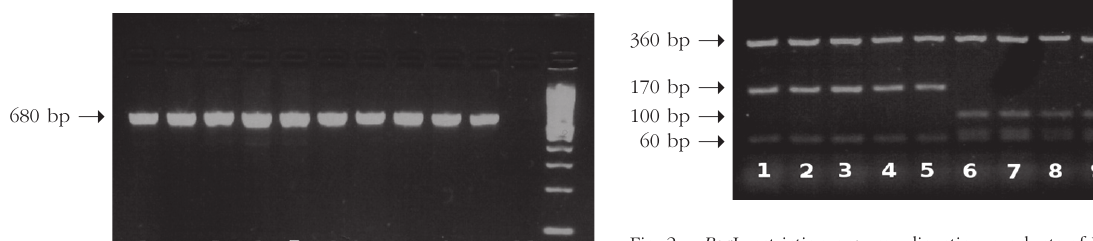
Fig. 2. – Rsa I restriction enzyme digestion products of ITS1 fragment. Lanes 1-5 denote to those of Fasciola gigantica isolated from cattle at Yaoundé, Cameron (1) and Cairo, Egypt (2, 3); as well as from sheep at Cairo, Egypt (4, 5), respectively. Lanes 6-10 denote to those of Fasciola hepatica isolated from sheep and cattle (6, 7) at Cairo, Egypt, and sheep and cattle (8, 9) at Tanta, Egypt, respectively, as well as from cattle at Limoges,